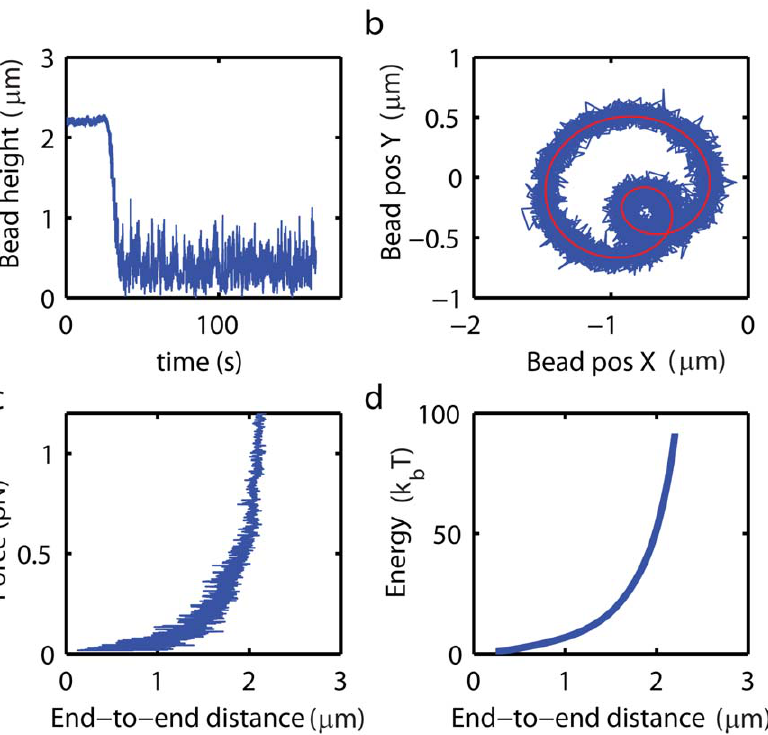
Figure 4. Fact characterization of the mechanical properties of a DNA-bead tether. A Characterization of the DNA length. The lowest bead height in the absence of an applied force is measured and the length is accordingly offset corrected. B Measurement of bead attachment offset from rotational response of the DNA-bead tether (cf. Fig. 3). C Dynamic measurement of the force-extension characteristic of the molecule. The length of the molecule was measured while linearly increasing the magnet height. The applied vertical magnetic force, F mag,z , is exponentially dependent on the magnet height (see sup Fig. S7). F mag , z ~ F 0 e { z mag = l dec . F 0 is a force-calibration factor that was characterized in an independent measurement to account for bead-to-bead variations in magnetic polarizability. D Energy versus extension curve allows extracting values for the persistence length and contour length with high fidelity [4]. Energy versus extension was calculated from the data in panel c using eq. (2). magnet configuration used in this experiment (Fig. S8). The data in Figure 4c shows a force versus end-to-end-distance curve (a 7.3 kb dsDNA) obtained after correcting for the bead-specific force calibration factor, F 0 = 6.0 pN, and the DNA-attachment length-offset, A = 0.01 m m.